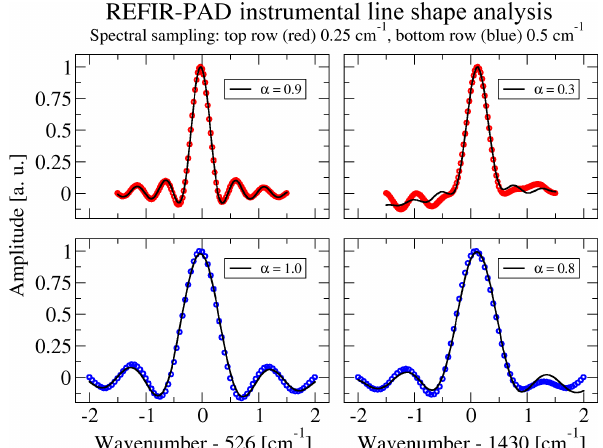
Figure 4. REFIR-PAD instrumental line shape. The blue line shows the isolated atmospheric line used for the analysis; the instrumental line shape is a linear combination of the sinc and sinc 2 components.